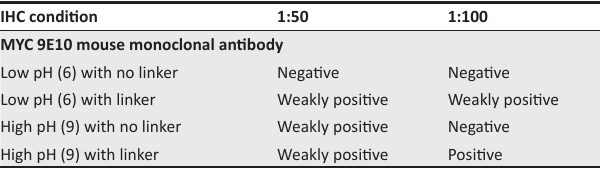
TABLE 2: The IHC optimisation staining results of the 9E10 anti-MYC